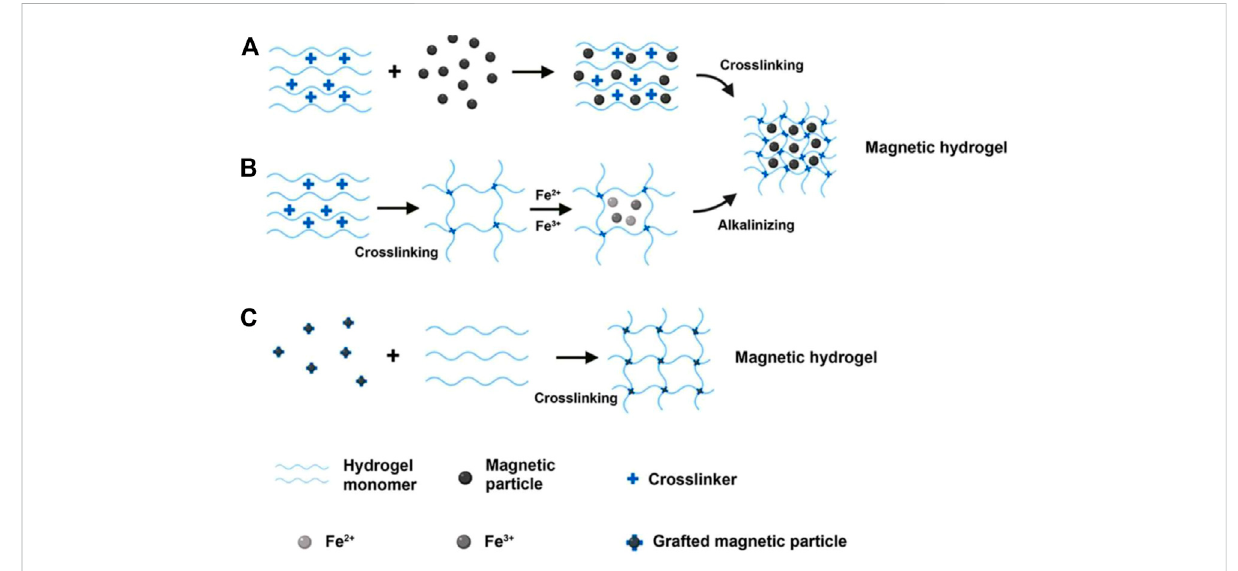
FIGURE 2 The schematic diagram of the main strategies for fabrication of magnetic hydrogels. (A) The blending method. (B) The precipitation method in situ . (C) The grafting-onto method [Reproduced with permission from (Liu et al., 2020) Copyright 2020